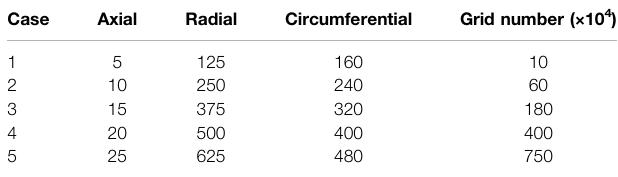
TABLE 2 | Grid number in different examples.